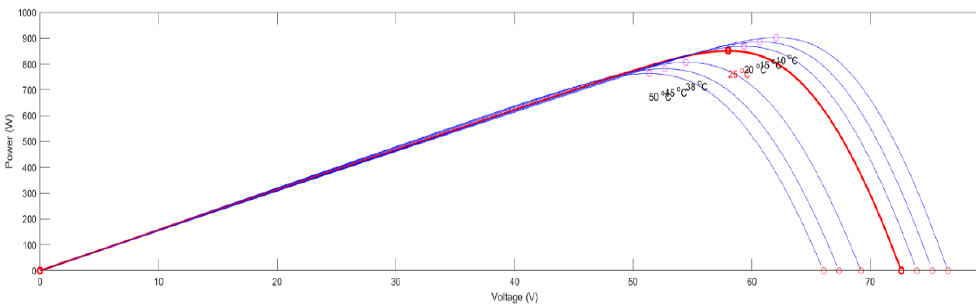
Figure 11. Power curve simulation of the selected panel in different temperatures.